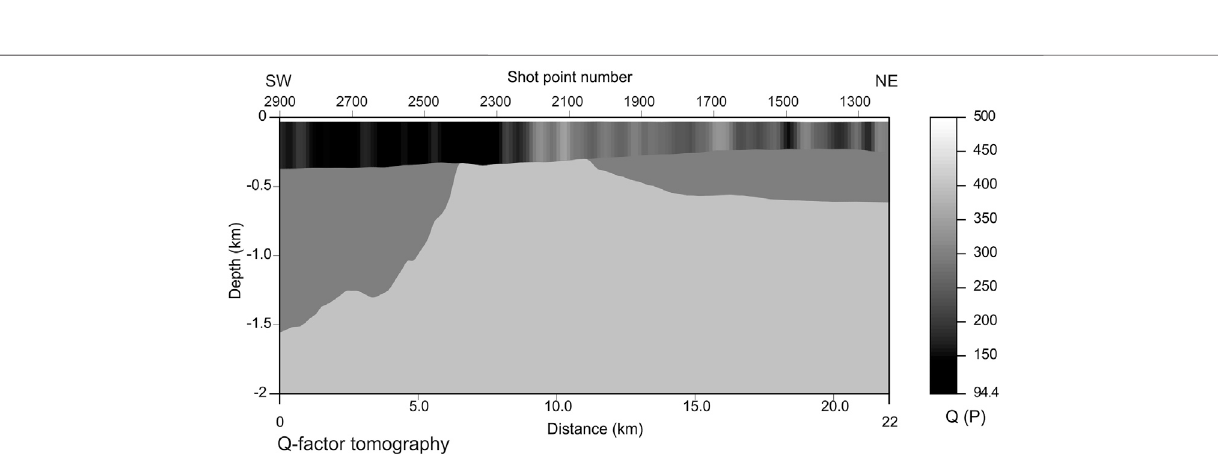
Frontiers in Earth Science |